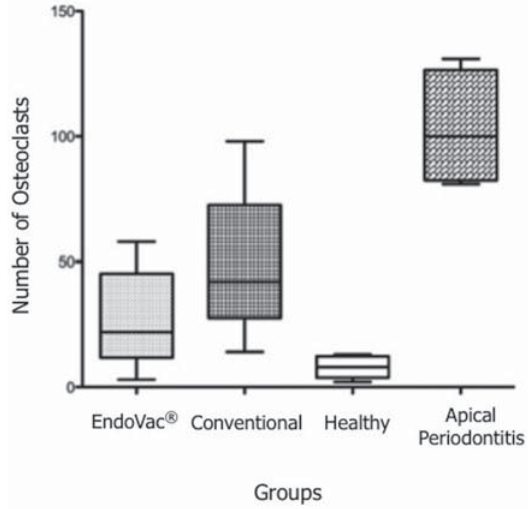
Figure 4- Distribution of the number of osteoclasts. The different